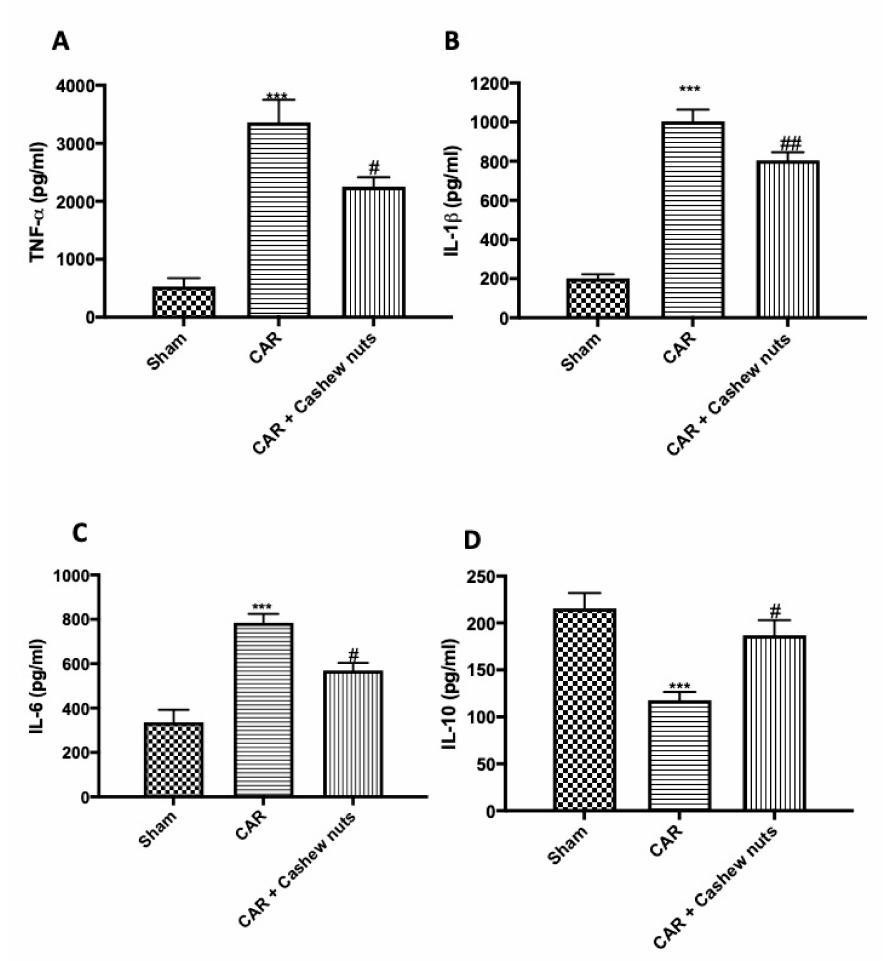
Figure 4. E ff ects of cashew nuts on cytokines production CAR-induced. Investigation of cytokines is mandatory when talking of inflammatory condition. As predicted, during CAR-caused inflammation, we observed a significant increase in TNF- α , IL-1 β , IL-6 levels; vice versa we observed a significant decrease in IL-10 production. Cashew nuts administration 30 min before CAR-injection at the dose of 100 mg / kg significantly reduced pro-inflammatory cytokines expression and, vice versa, increased anti-inflammatory expression of IL-10. TNF- α ( A ), IL-1 β ( B ), IL-6 ( C ), and IL-10 ( D ). See materials and methods for further details. # p < 0.05 vs. CAR; ## p < 0.01 vs. CAR; *** p < 0.001 vs.